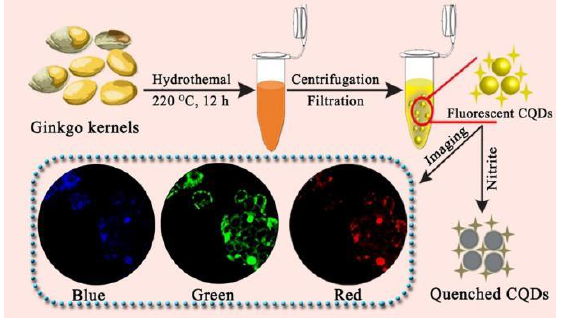
Figure 4. Schematic illustration of the preparation process of CQDs and its determination of nitrite ions and cell imaging. Adapted with permission from Zhang et al., 2022. Copyright 2022. Reproduced with permission from Elsevier [41].